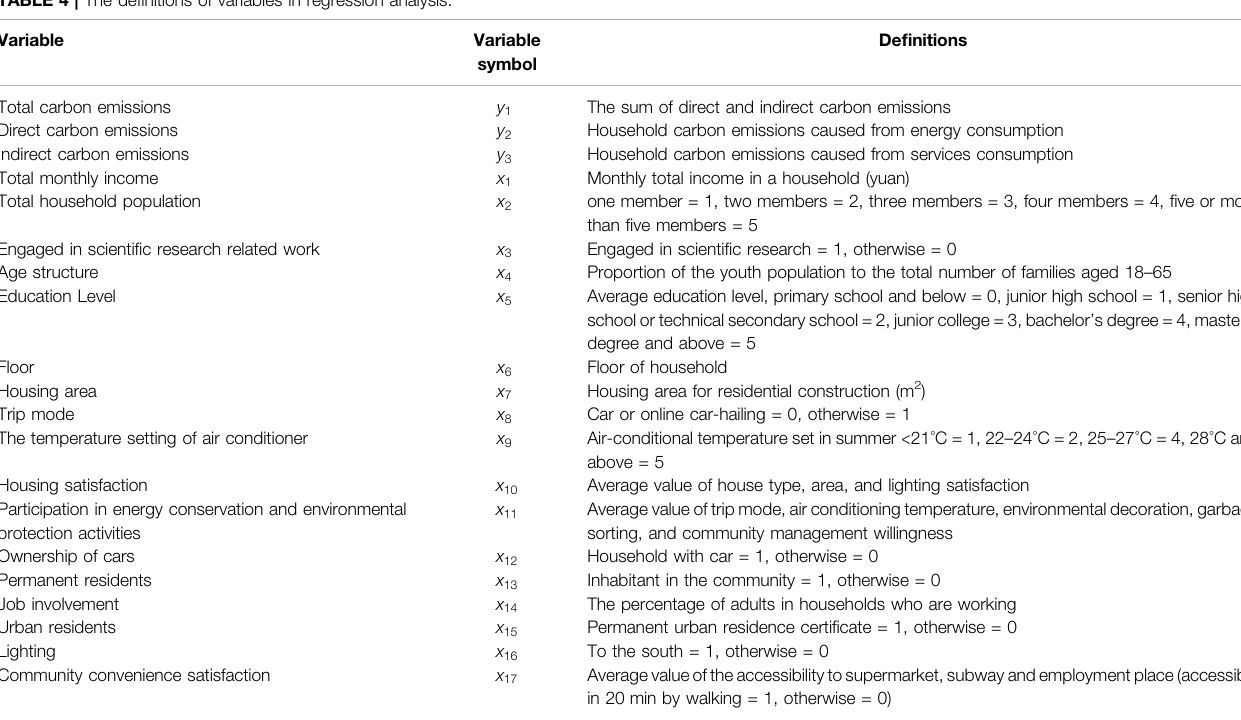
TABLE 4 | The de fi nitions of variables in regression